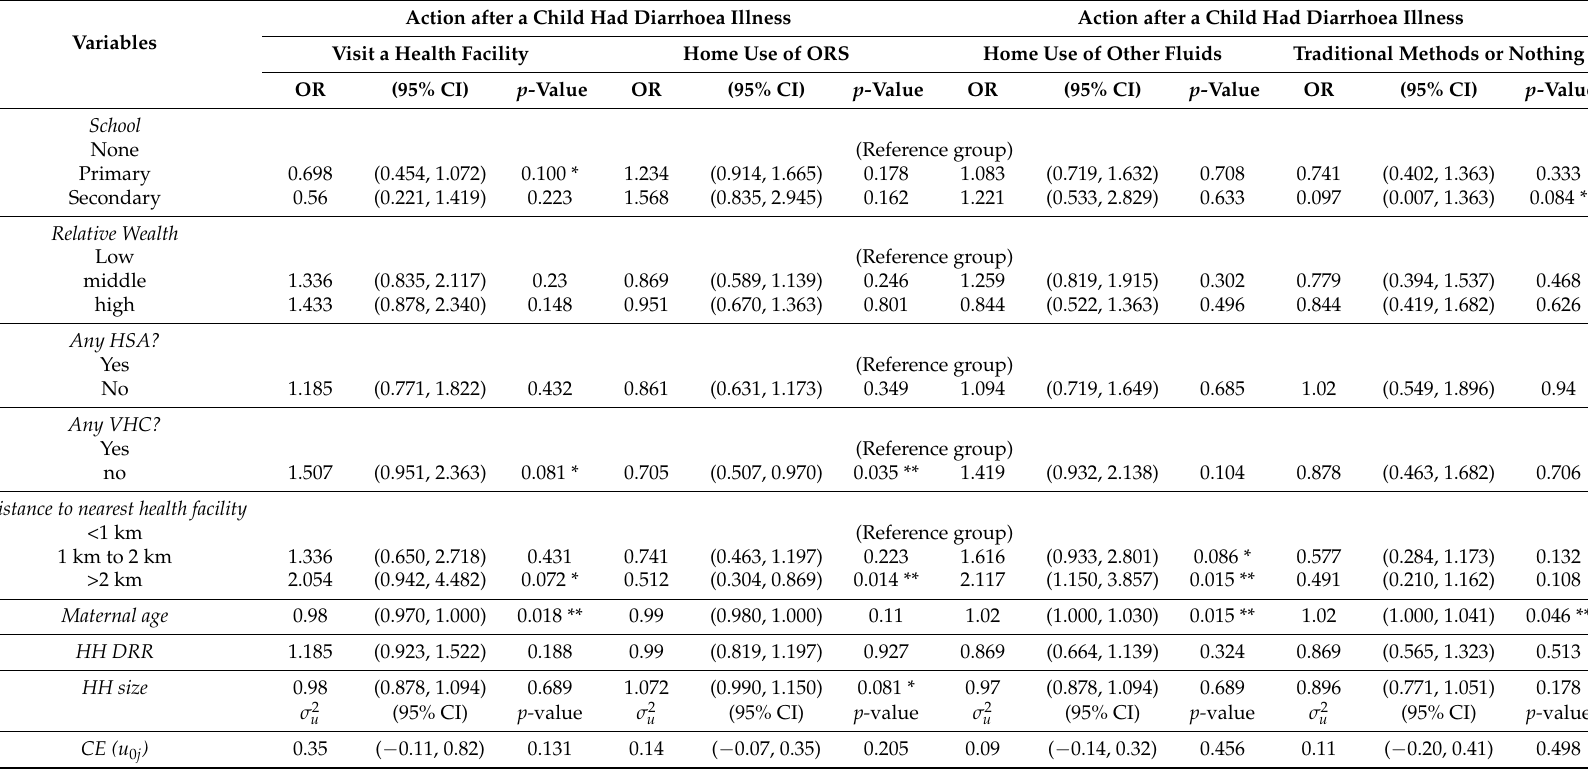
Table 4. Multilevel logistic regression models to identify determinants of household care-seeking behaviour when a child had